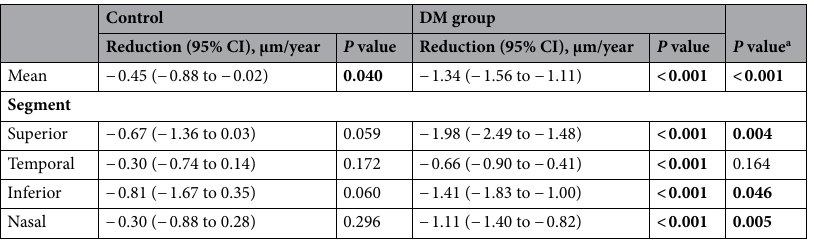
Table 2. Estimated mean rates of reduction in peripapillary retinal nerve fiber layer from the linear mixed model. Values in boldface ( P < 0.05) are statistically significant. a Calculated for interaction between groups and follow-up duration in the linear mixed